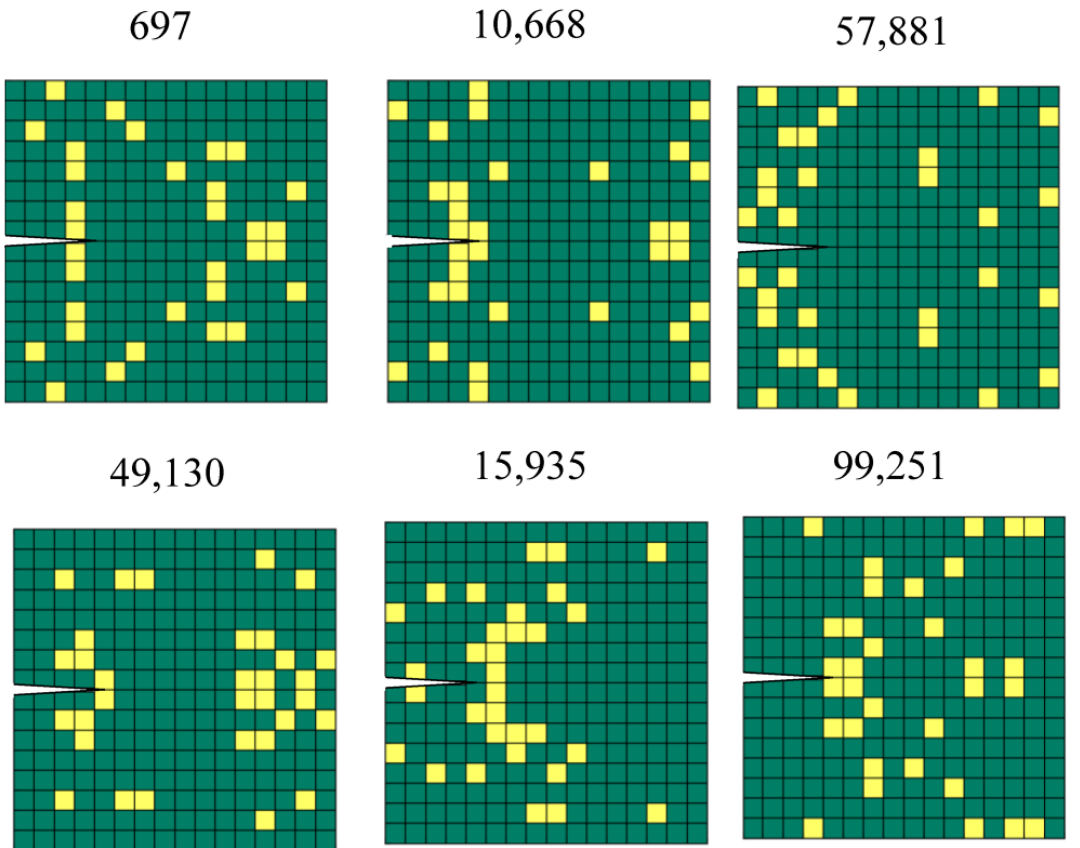
Figure 8. 6 Design patterns for the experiment. The number denotes the pattern ID. Table 2. Comparison of simulated and experimental stiffness K (* soft material ahead of the crack tip.).